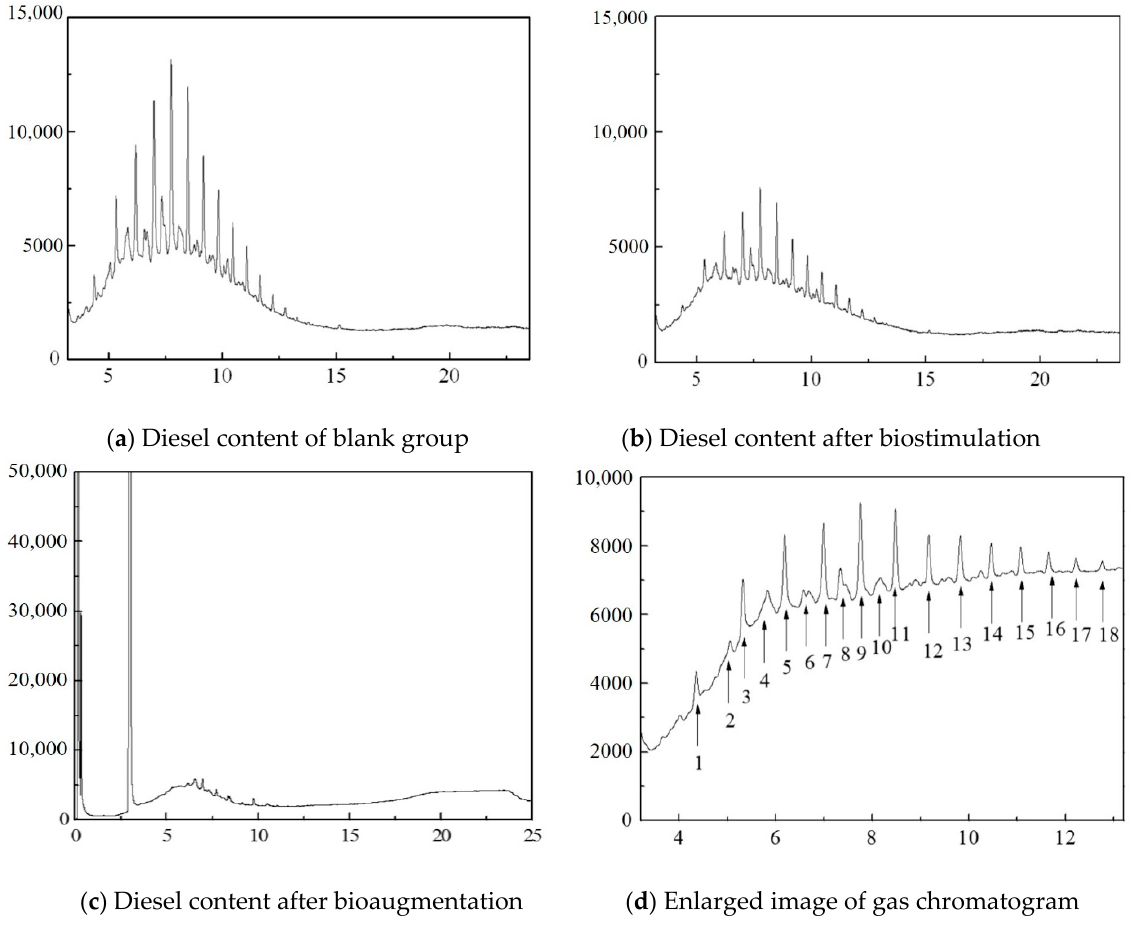
Figure 4. Diesel content and structural composition of different treatment methods.